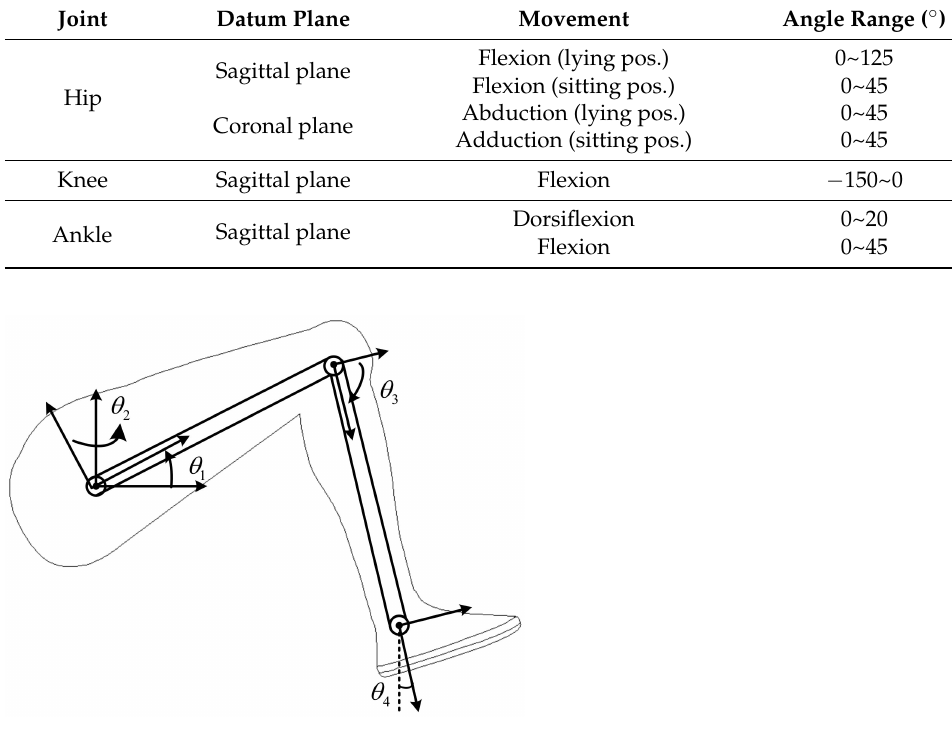
Figure 1. Lower limb analysis of a healthy